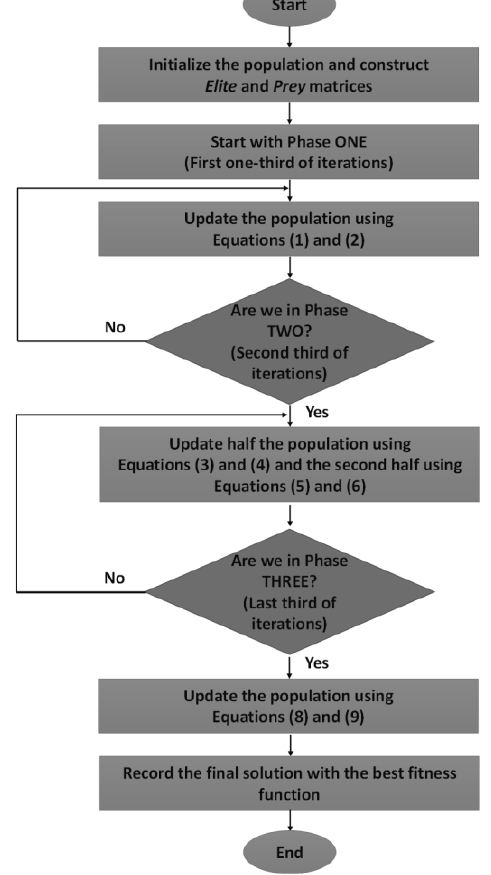
Figure 2. Flowchart of the MPA optimization method.